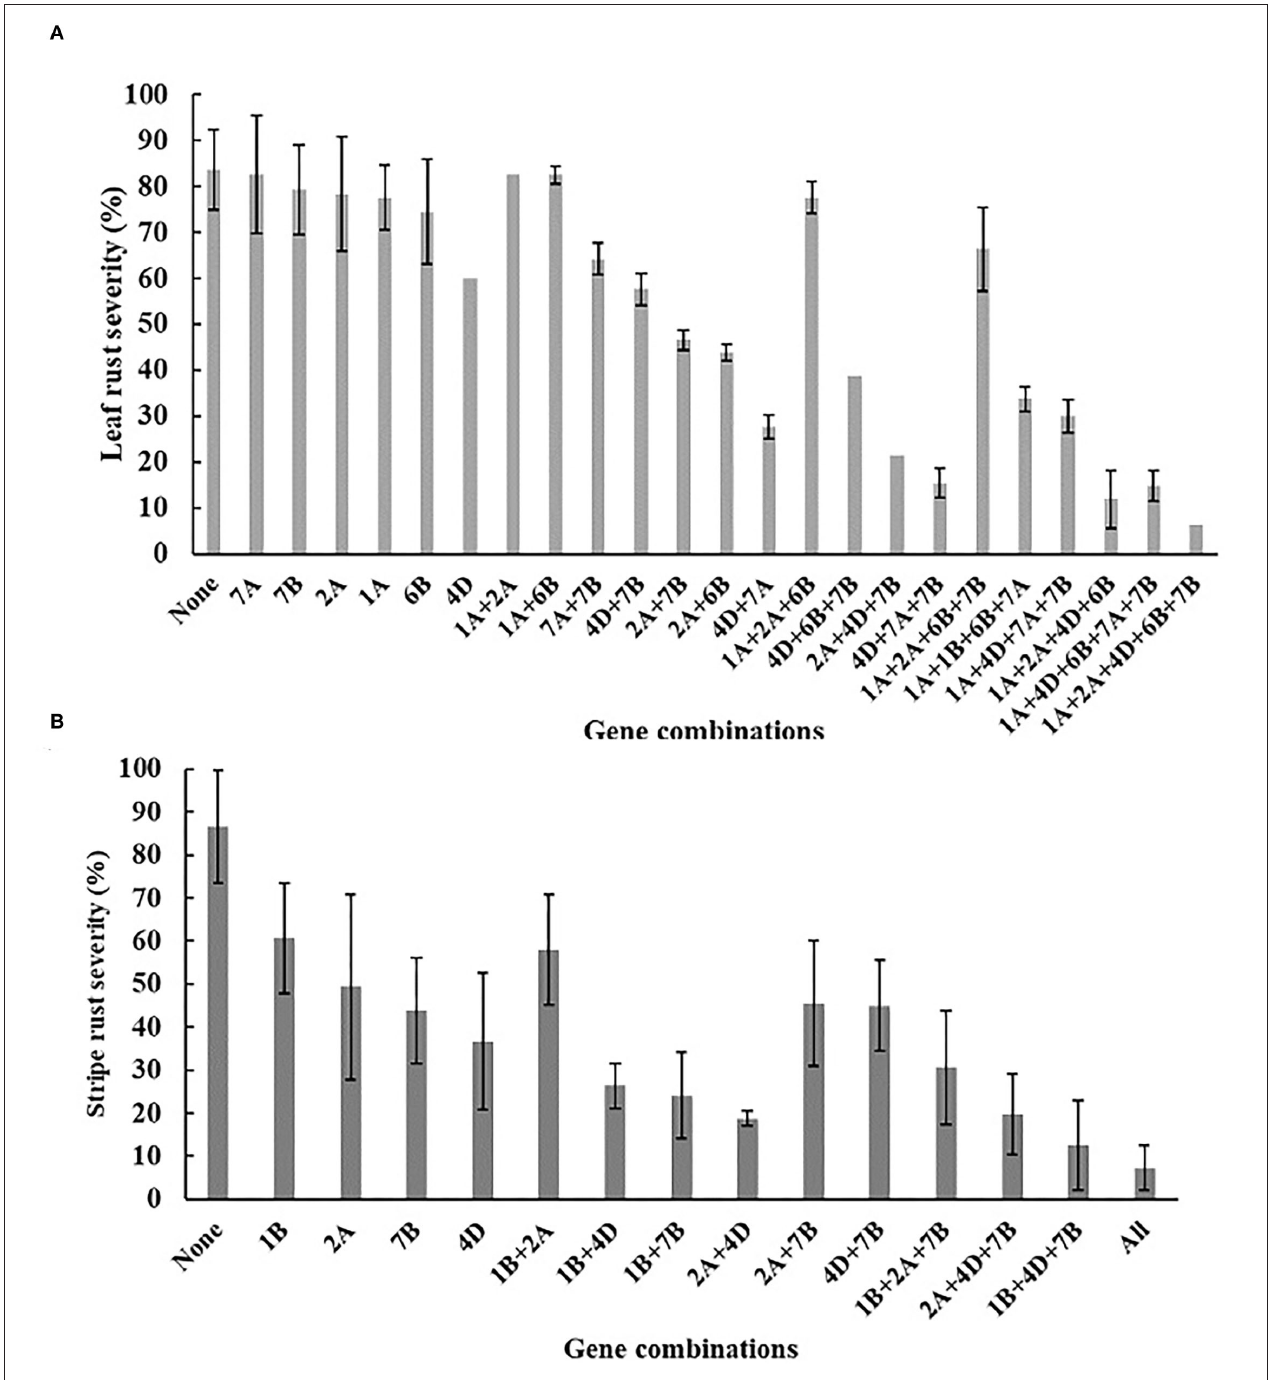
FIGURE 4 | Mean MDS of lines carrying different combinations of QTLs. Lines containing the different QTL combinations were grouped together and the corresponding rust severities were averaged over environments. (A) Corresponds leaf rust combinations, (B) Corresponds to stripe rust evaluations. Means and standard errors of the means are